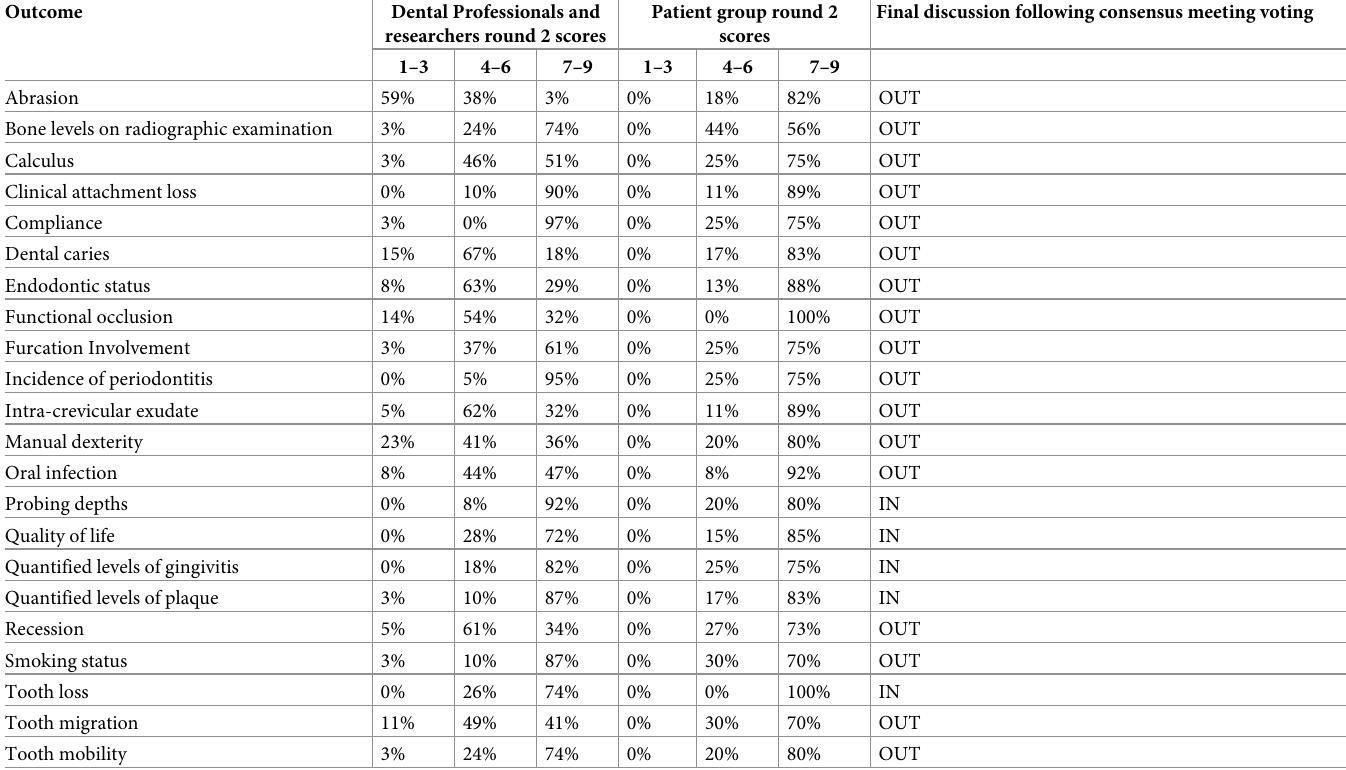
Table 3. Final 22 outcomes taken forward to consensus meeting (in alphabetical order).